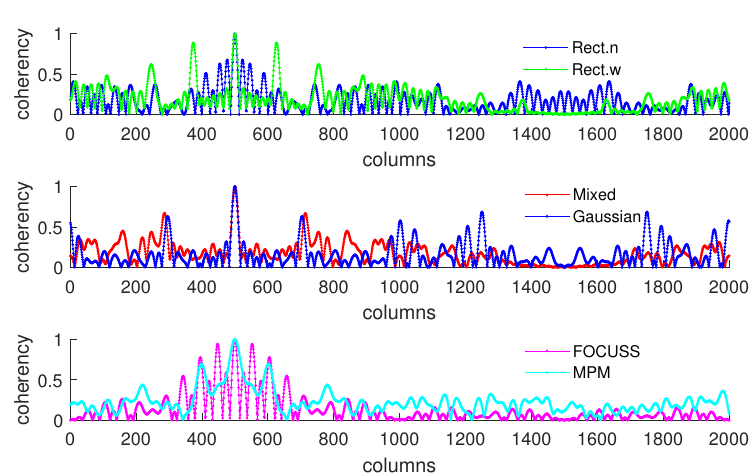
Figure 6. Coherence curve of each subarray generated in Simulation 1 at direction θ = π /6 when σ p = 30.